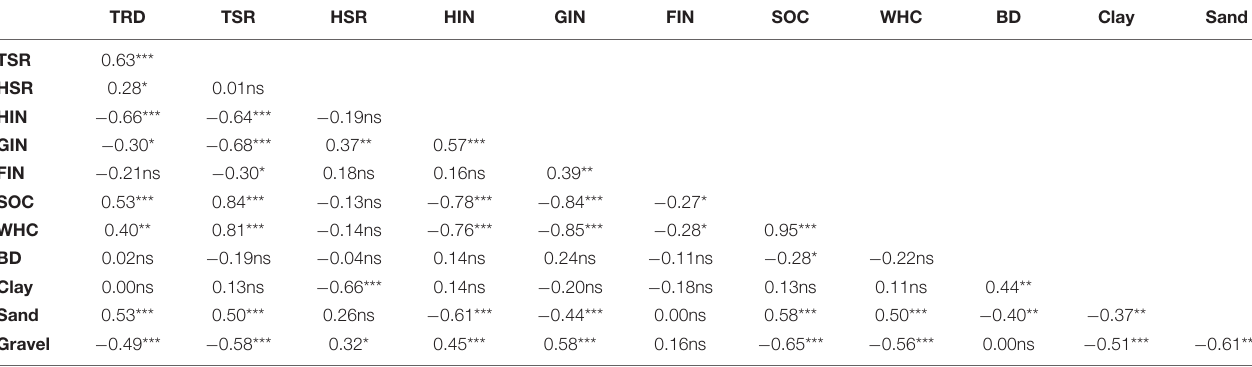
TABLE 1 | Summary of Pearson’s correlation among various habitat characteristics across the low and high disturbance sites. TRD TSR HSR HIN GIN FIN SOC WHC BD Clay Sand